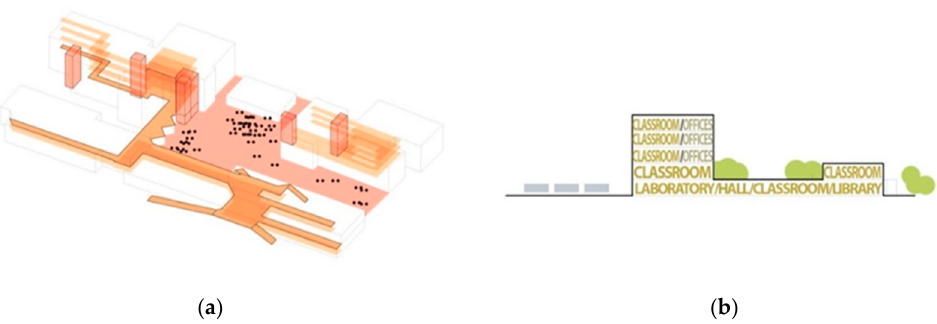
Figure 8. FS: main circulations scheme ( a ) and cross-section ( b ). Drawings: Carlos Pastor García.